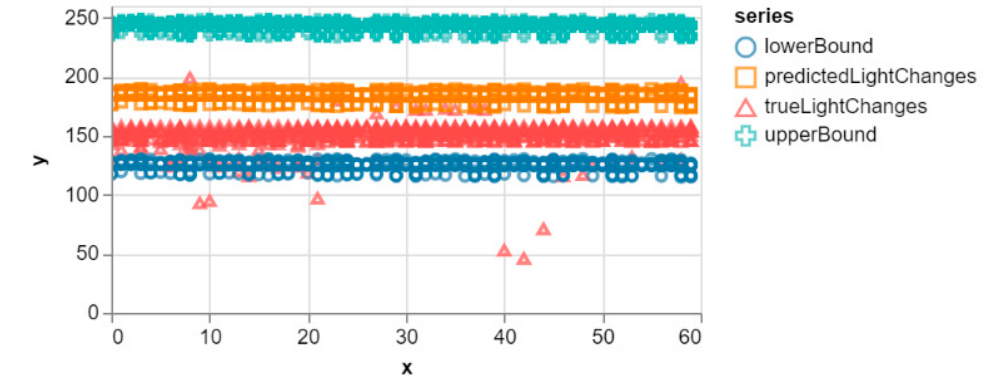
Figure 9. Test result for the default dataset on the adapted model showing the adaptive nature of the proposed architecture. The x-axis represents time (in seconds) while the y-axis represents the light intensity in LUX.